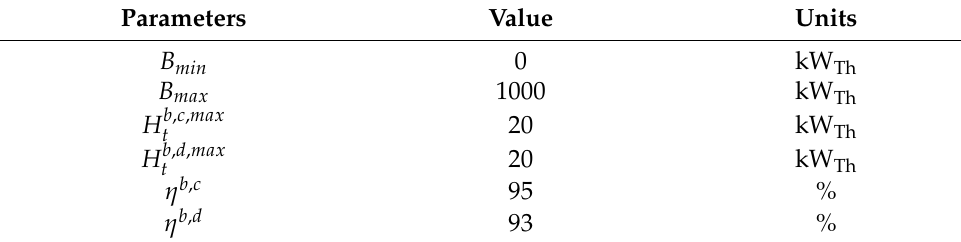
Table 5. Parameters of thermal energy storage.